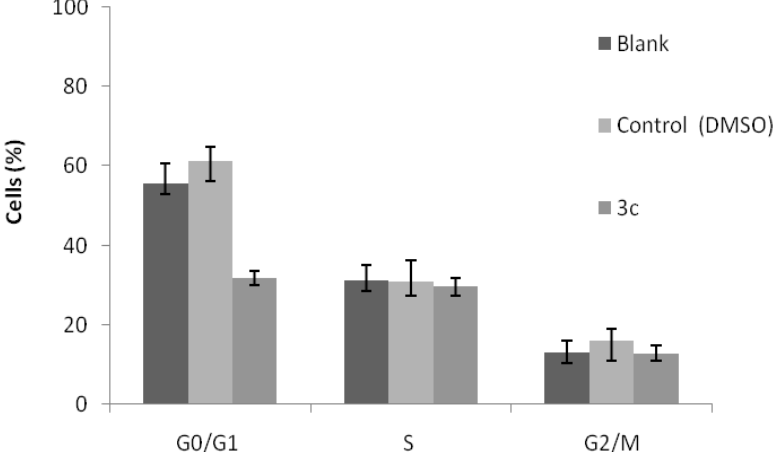
Figure 1. Cell cycle analysis of NCI-H460 cells treated with compound 3c at its GI concentration (1.4 μ M). Untreated cells (blank) and compound vehicle (DMSO) were used as controls. Results are the mean ± SEM of three independent